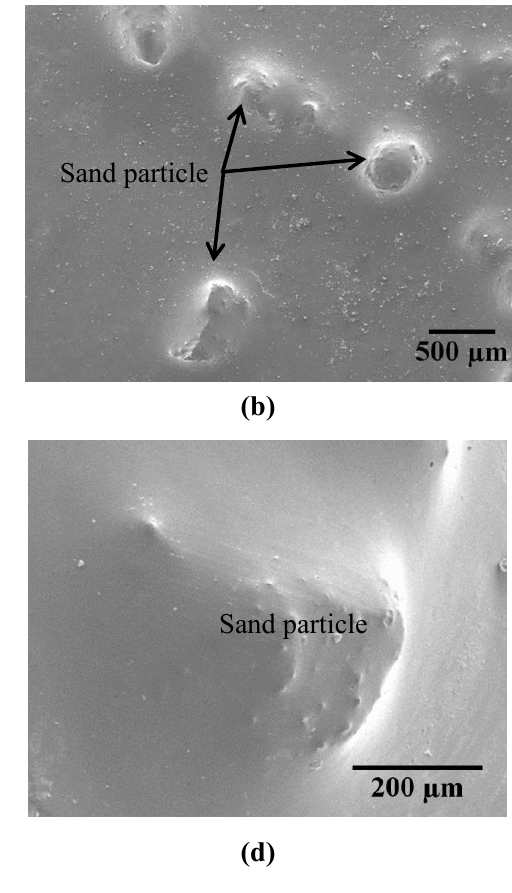
Figure 2. SEM images of enamel coating with 70 wt% sand particles: ( a ) steel-enamel cross-section; ( b ) enamel coating surface; ( c ) sand particle with micro-crack; and ( d ) sand particle without